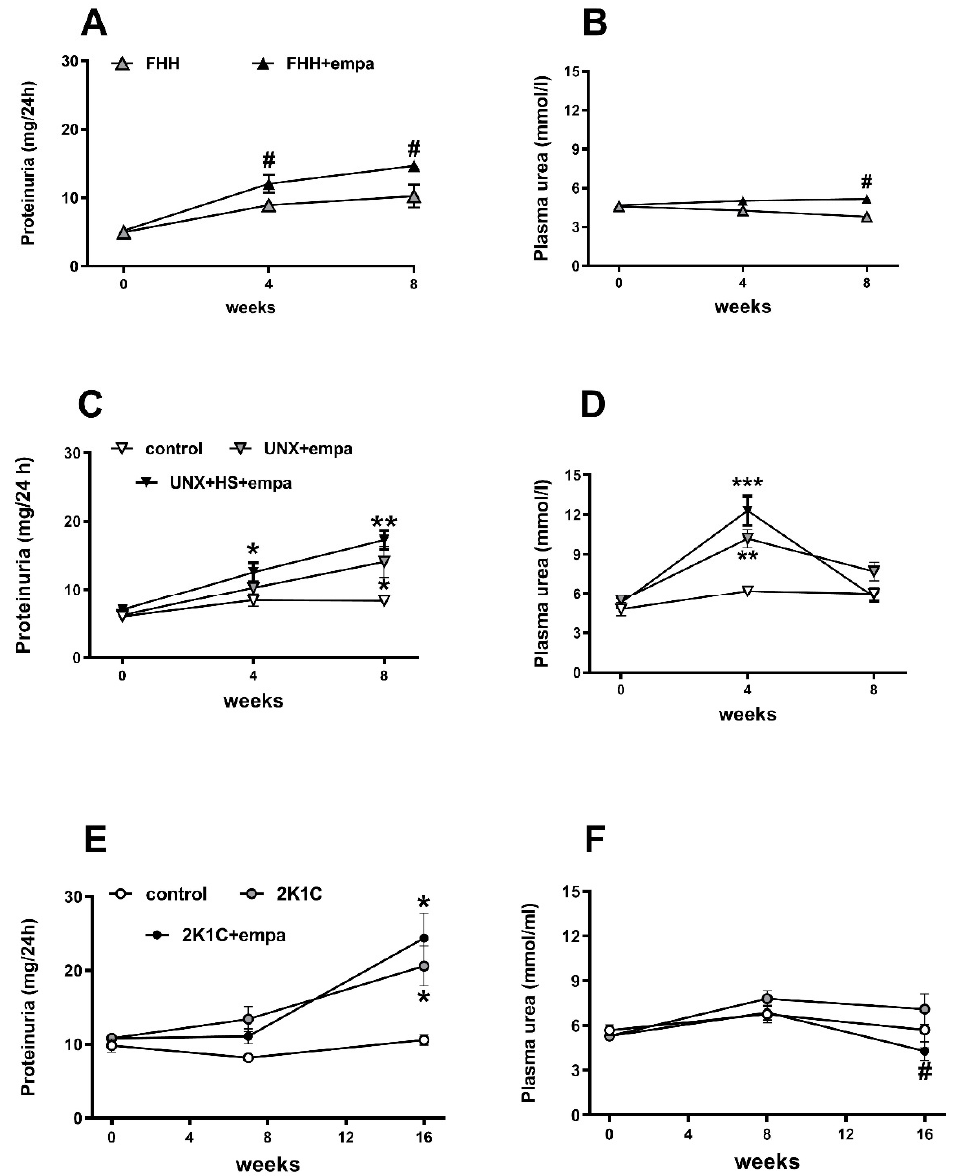
Figure 4. The effect of empagliflozin treatment on proteinuria ( A , C , E ) and plasma urea ( B , D , F ) in fawn-hooded hypertensive (FHH) rats ( A , B ), uninephrectomized (UNX) Hannover Sprague Dawley (HanSD) rats on high-salt (HS) diet ( C , D ), and Wistar rats subjected to renal artery stenosis (Goldblatt 2K1C hypertension) ( E , F ). * p < 0.05 vs. control group, # p < 0.05 vs. untreated group. * denotes p < 0.05; ** denotes p < 0.01; and *** denotes p < 0.001; data are means ± SEM. At the end of the study, plasma creatinine was decreased in HanSD-UNX rats, while it was not changed in Wistar-2K1C and in FHH following empagliflozin treatment (Figure